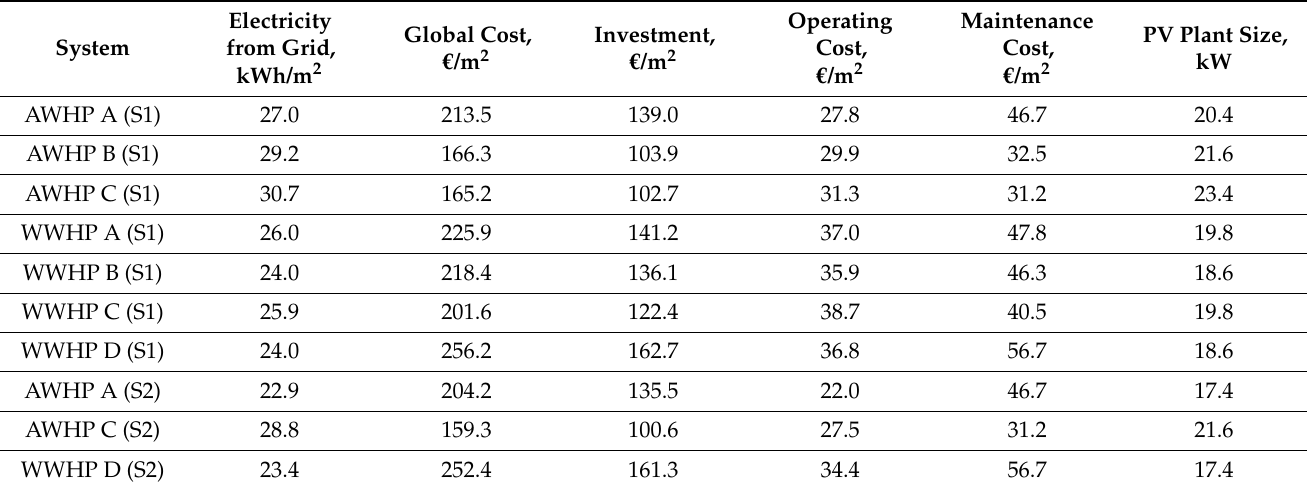
Table 7. Energy, cost and efficiency indicators and PV plant size (PV collectors covering nonrenewable electricity consumption).